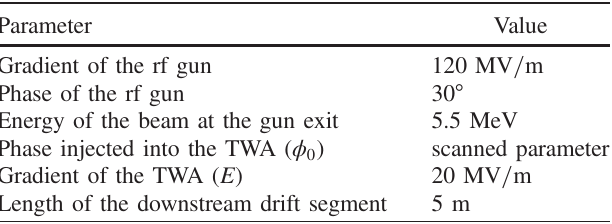
TABLE I. Parameters of the TTX beamline setup. Parameter